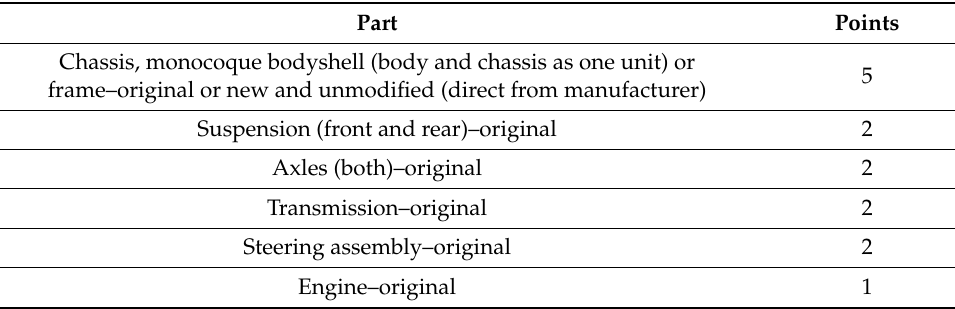
Table 5. ‘Radically altered vehicle’ point scoring system [129]. Part